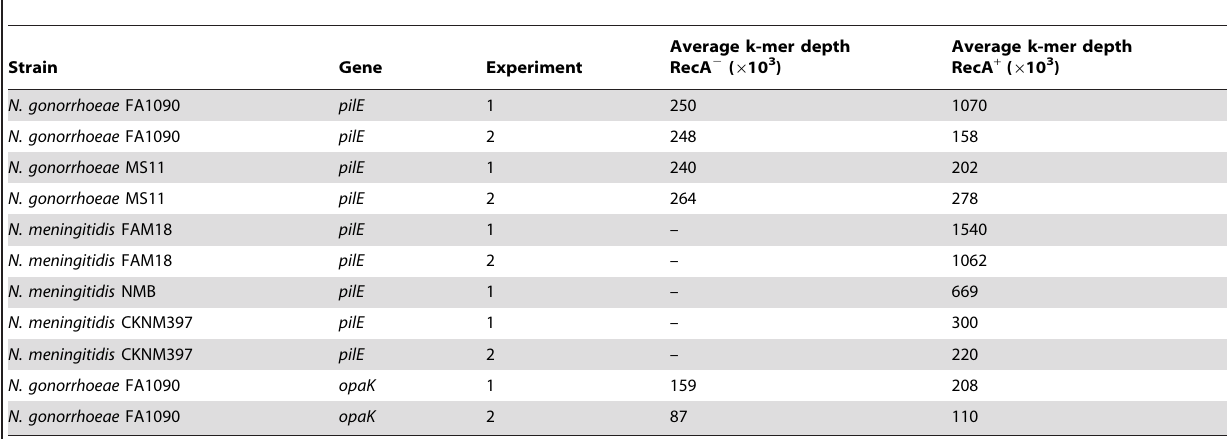
Table 2. Average k-mer depth of allele 1, the sequence assembly that was identical to the reference sequence, for each